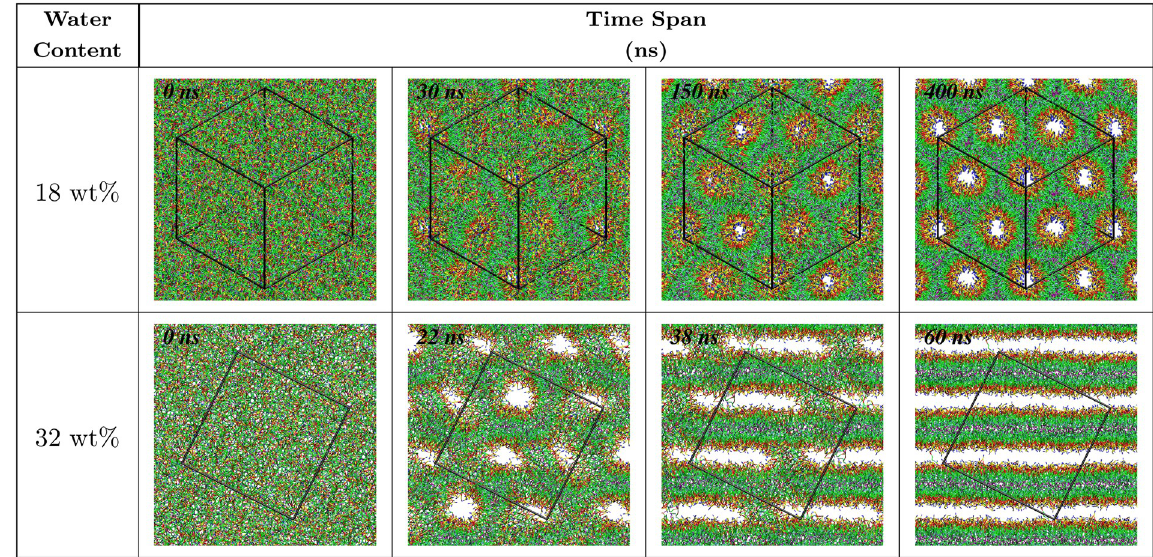
Fig 7. Snapshots of CG simulations of 1000 lipid molecules at two different water contents using the HC model showing formation of L α and H II lipid